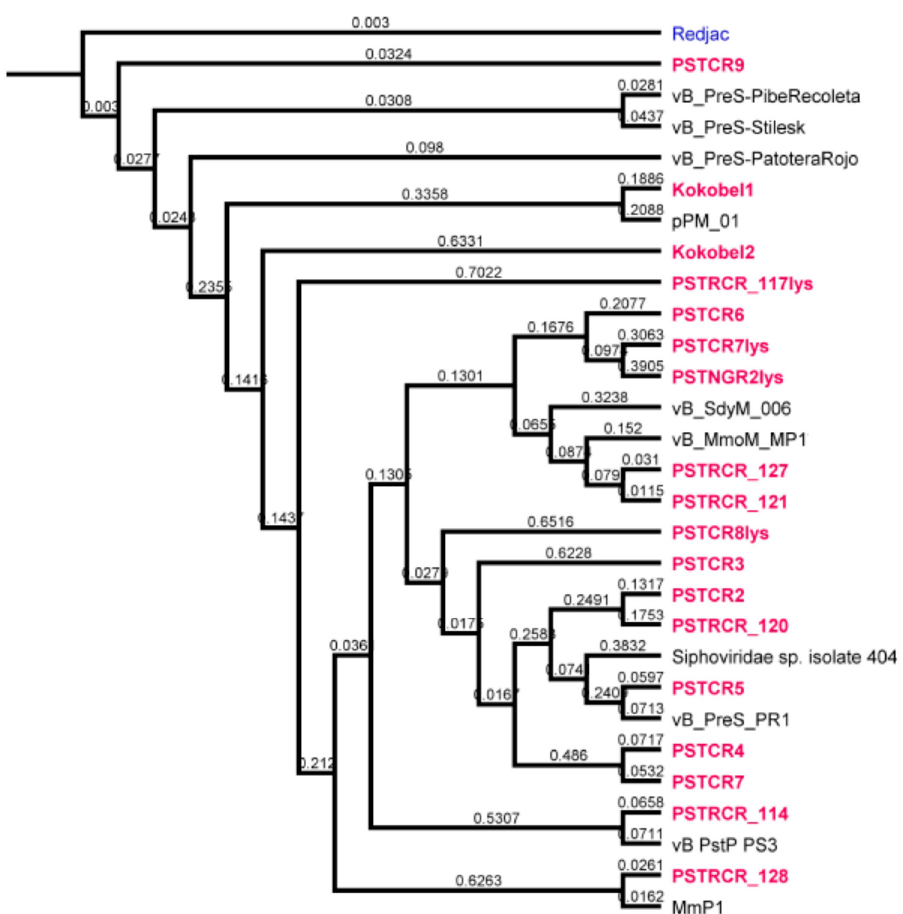
Figure 2. Genome analysis of Providencia phages. Phylogenetic tree of Providencia phages. Phages of this work are shown in red. Close-similar genomes of fully sequenced phages from the NCBI database are given as reference points shown in black.